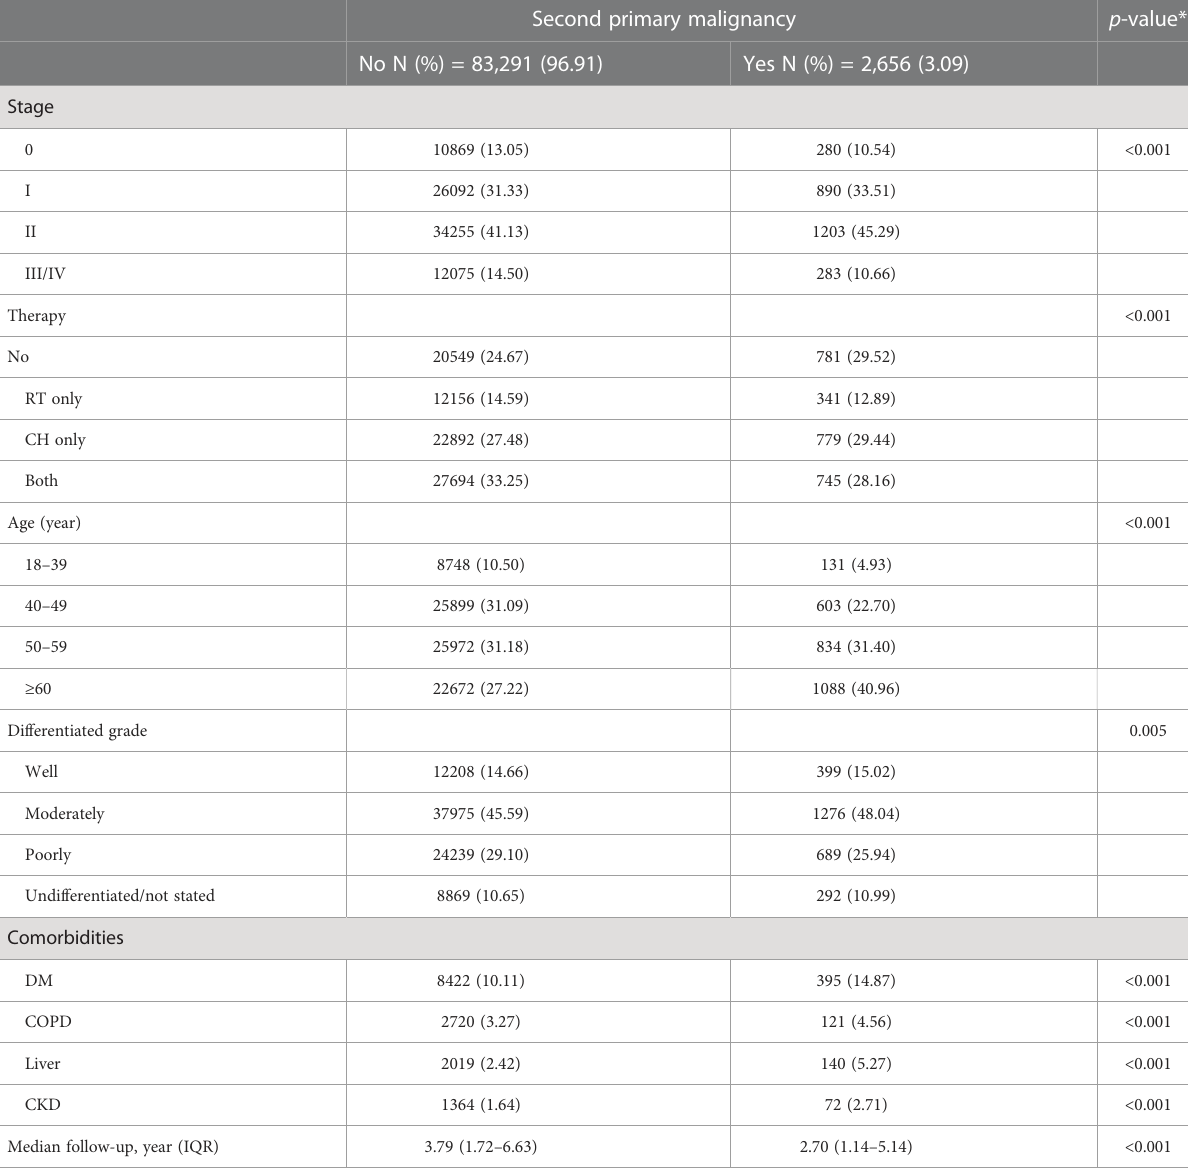
TABLE 3 Overall demographic information of patients with breast cancer with and without second primary